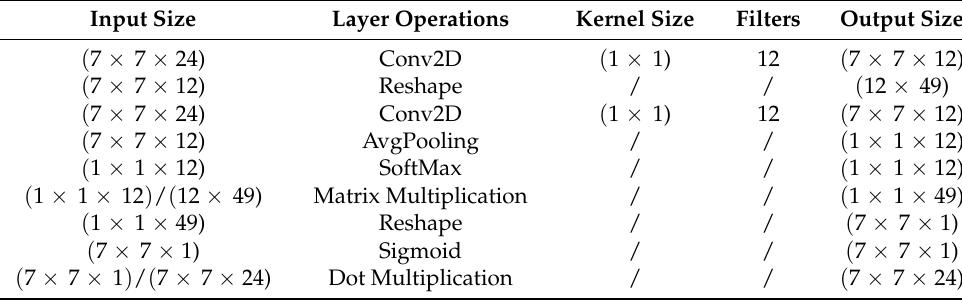
Table 4. Detailed steps of the spatial-only polarized attention block.